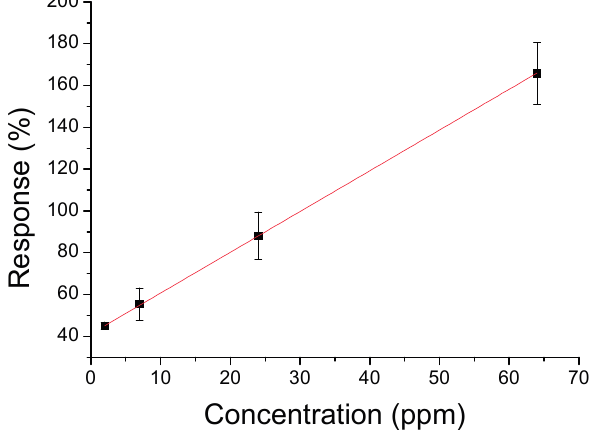
Figure 10. Linear response of a sensor with 90 s deposition time and 450 °C annealing temperature to acetone at 300